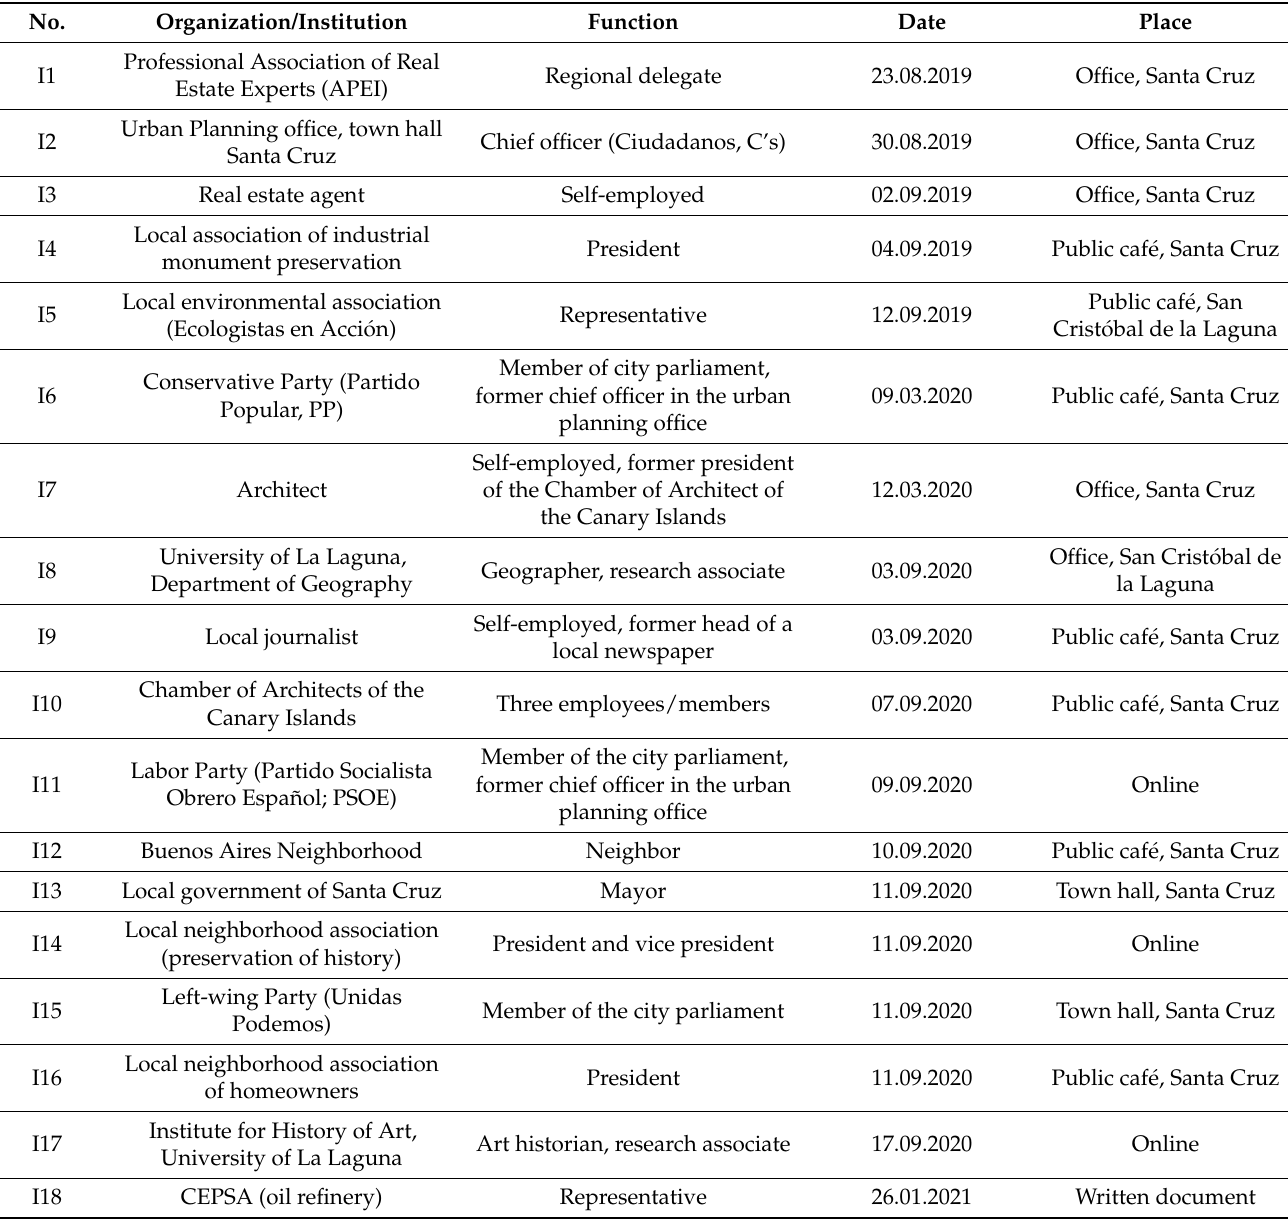
Table 1. Overview of the